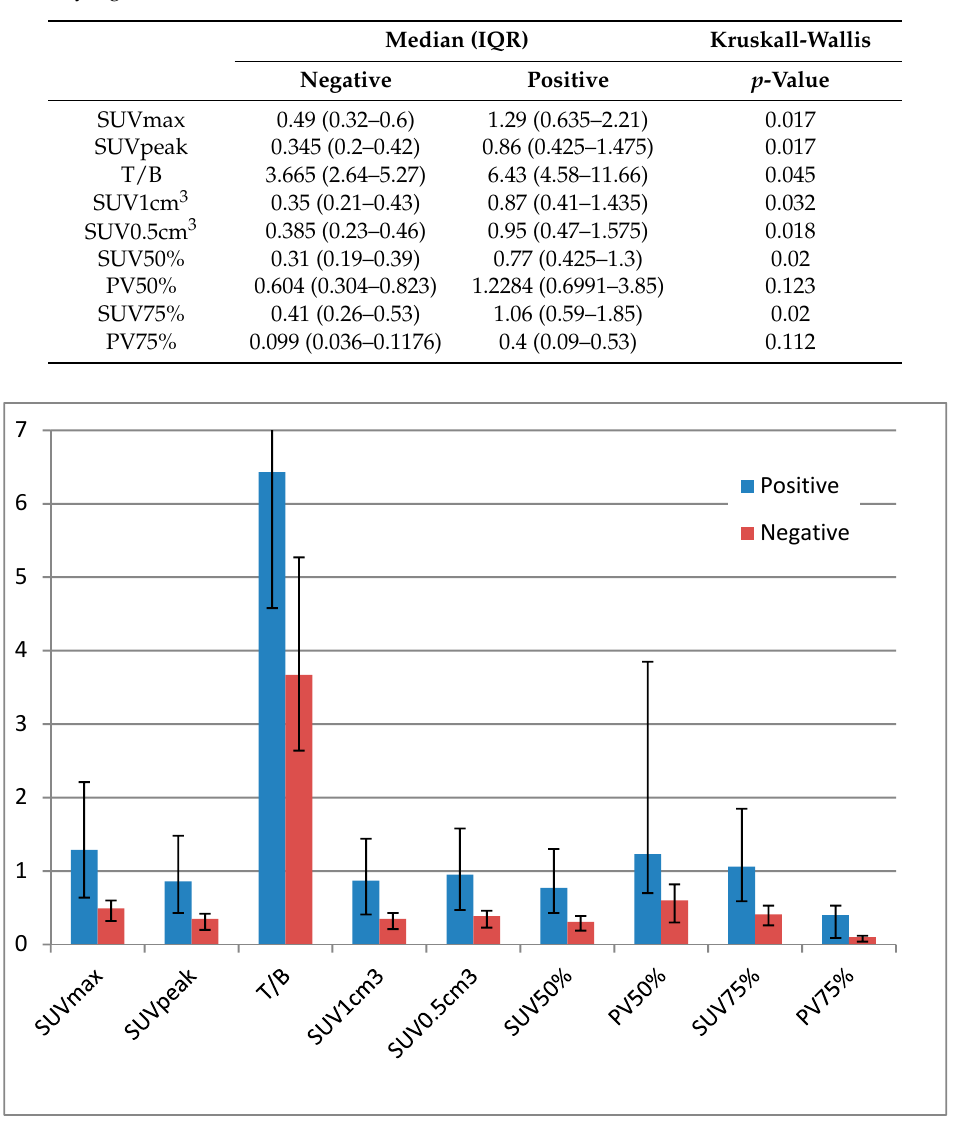
Table 3. Median (interquartile range) of different parameters for positive and negative lesions. Comparisons were made with a non-parametric Kruskall-Wallis test. p < 0.05 is considered statistically significant.